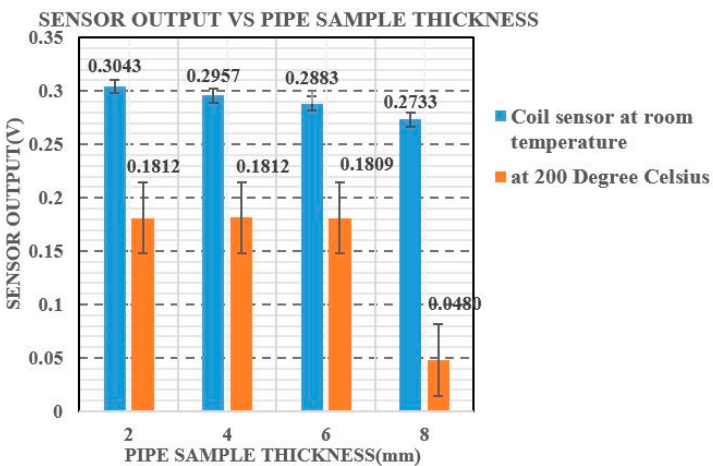
Figure 10. Comparison of the output voltage of the MFL coil sensor at room temperature and at 200 °C.